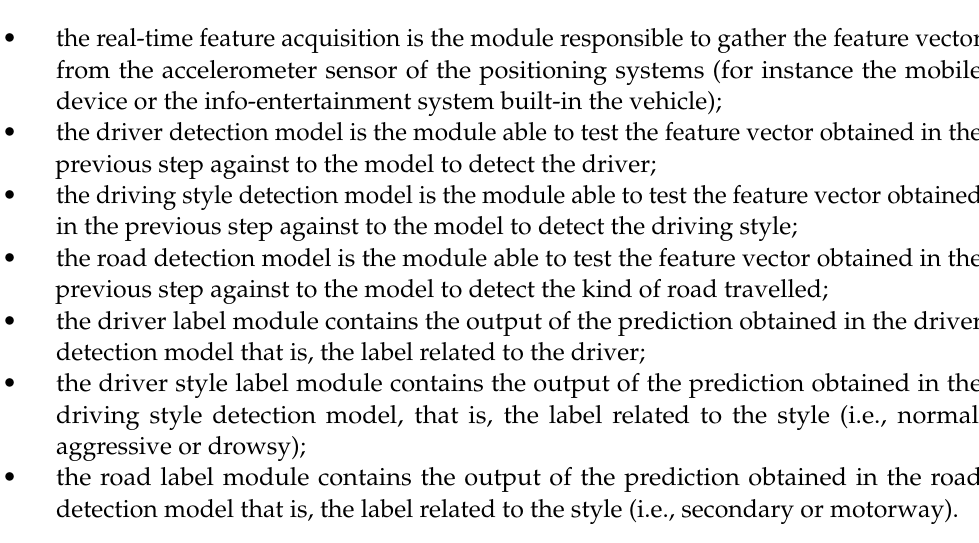
Figure 4. The flow diagram related to the intelligence